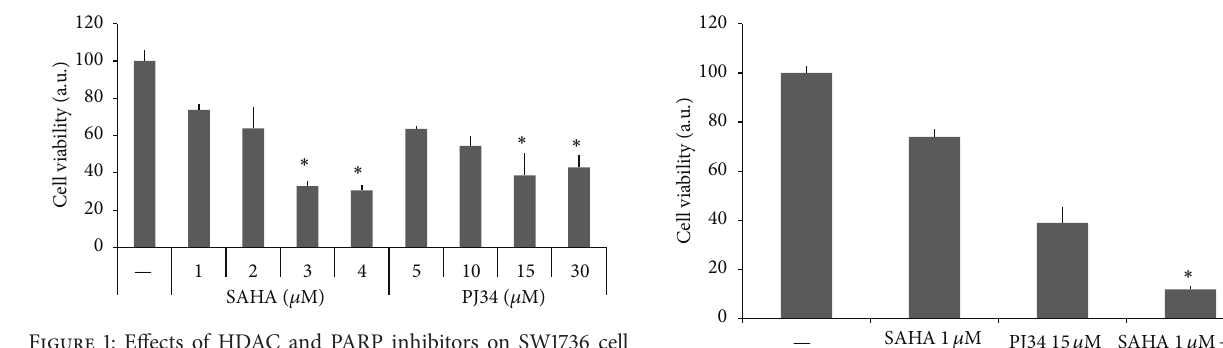
Figure 1: Effects of HDAC and PARP inhibitors on SW1736 cell viability. Cells were treated for 72 h with SAHA (1 𝜇 M–4 𝜇 M) or PJ34 (5 𝜇 M–30 𝜇 M), and CellTiter-Blue Cell Viability assay was performed as described in Section 2. Bars indicate the percentage of viable cells versus controls (untreated cells) and represent means ± SD of three experiments. ∗ indicates values significantly different compared to control. Table 1: Combination index data for SAHA and PJ34 combination.